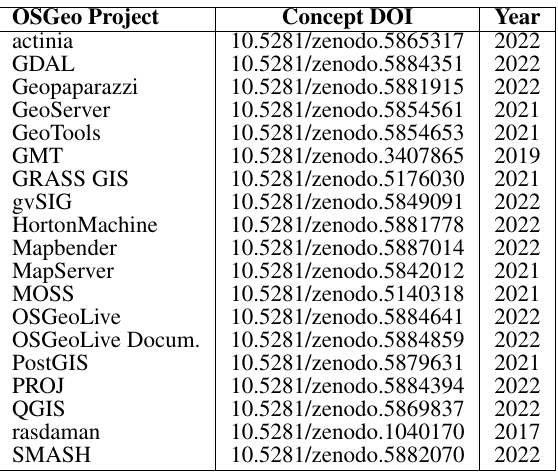
Table 1. Alphabetical list of OSGeo projects which have registered DOI (June 2022).